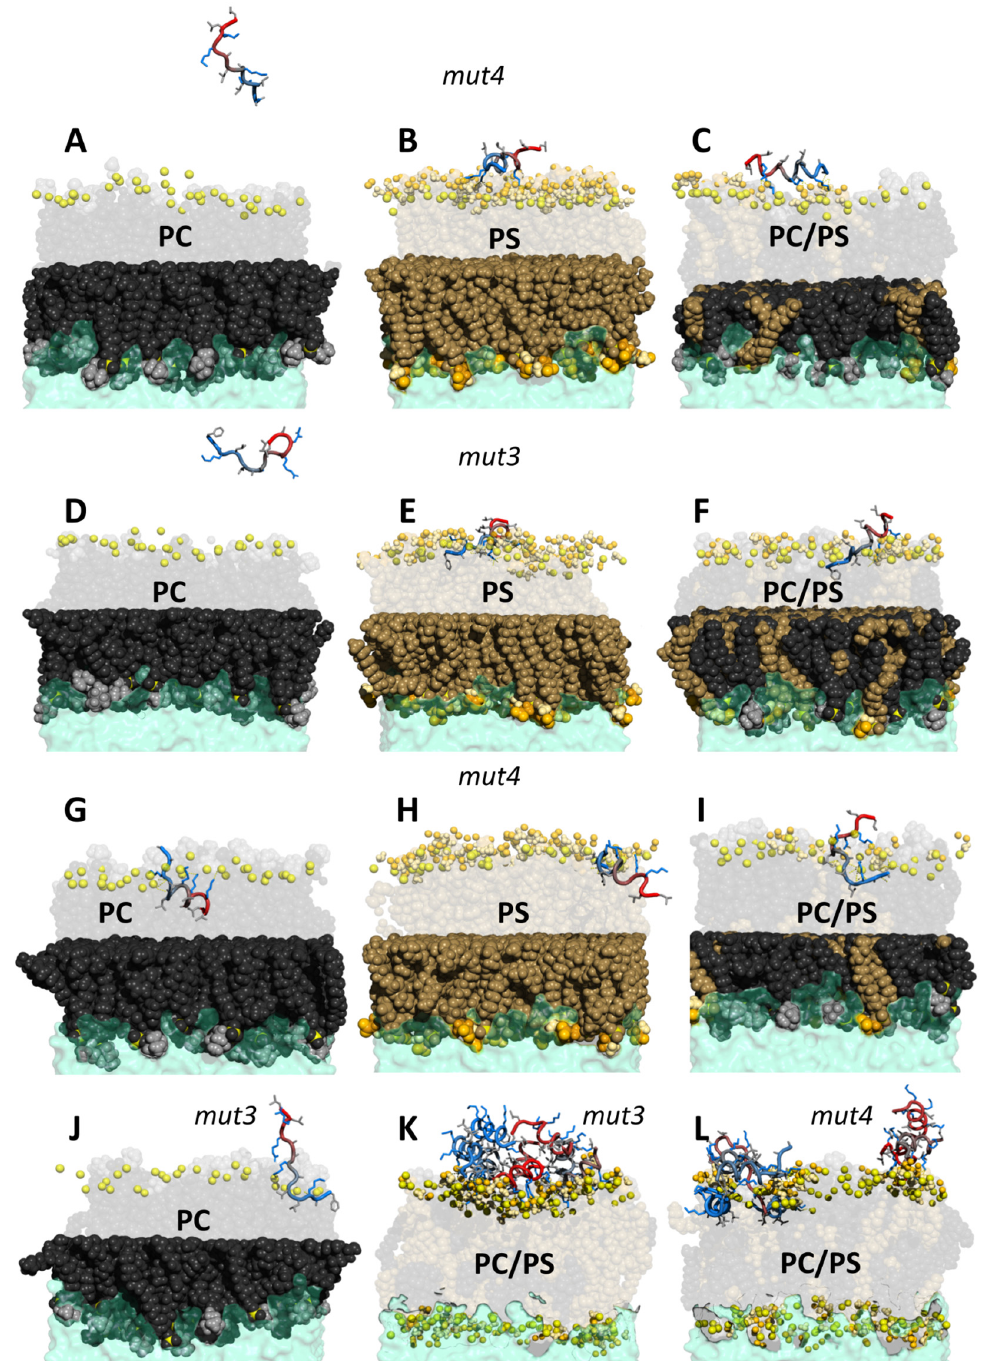
Figure 7. MD snapshots of mut3 and mut4 interacting with model membranes of various phospholipid compositions ( A – F ). Color code: phosphorus atom: yellow, POPC black (body) and light gray (choline group), POPS brown (body), gold (headgroup), light yellow (amine of the headgroup), and orange (carboxyl of the headgroup). For clarity, only functional groups of headgroups are shown (spheres) in the upper leaflet. mut3 and mut4 are shown as a ‘tube’ colored from blue (N-terminus) to red (C-terminus). Sidechains are shown as sticks with the following color code: positively charged (blue) and nonpolar (light gray). Snapshots in panels ( G – L ) refer to rare events observed along the trajectories. Data on HB43 peptide were previously published [42].